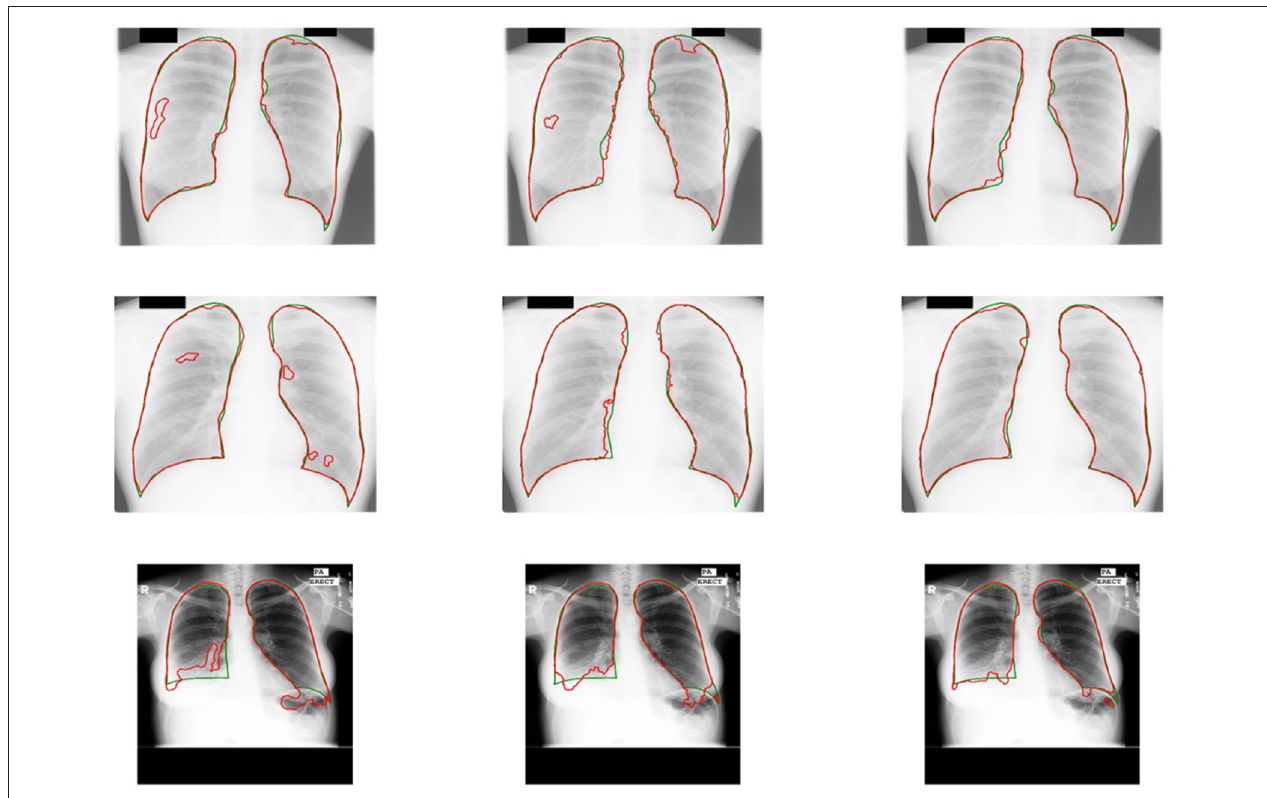
FIGURE 7 | Comparison of the results of U-shaped GAN with different training approaches on confusing samples. The radiographs in the first row are results of the supervised approach. The second row is the results of the original approach. The third row is the results of the semi-supervised approach. Green and red contours indicate the ground truth and automatic segmentation results,